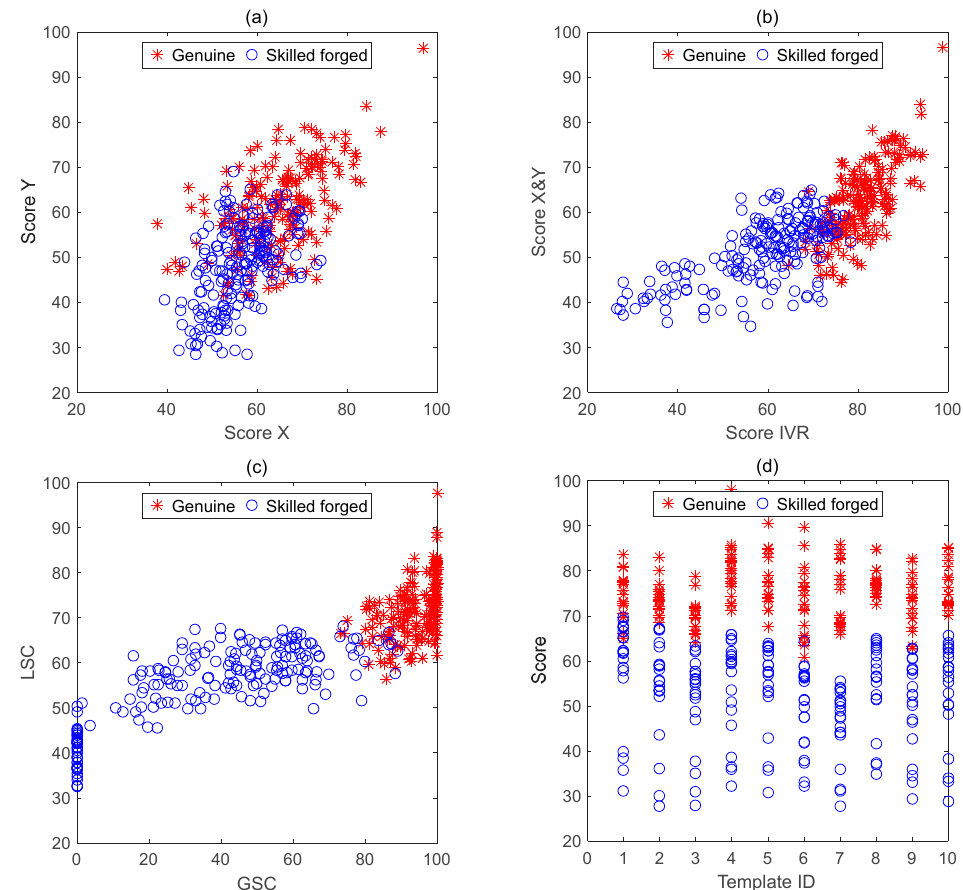
Figure 10. One of the first 10 genuine signatures is used as the template signature in turn, and the remaining genuine and skilled forged signatures are used as the comparison result of the test signatures. ( a ) Score X and score Y distribution; ( b ) Score IVR distribution; ( c ) GSC and LSC distribution; ( d ) 10 templates in turn Score distribution.